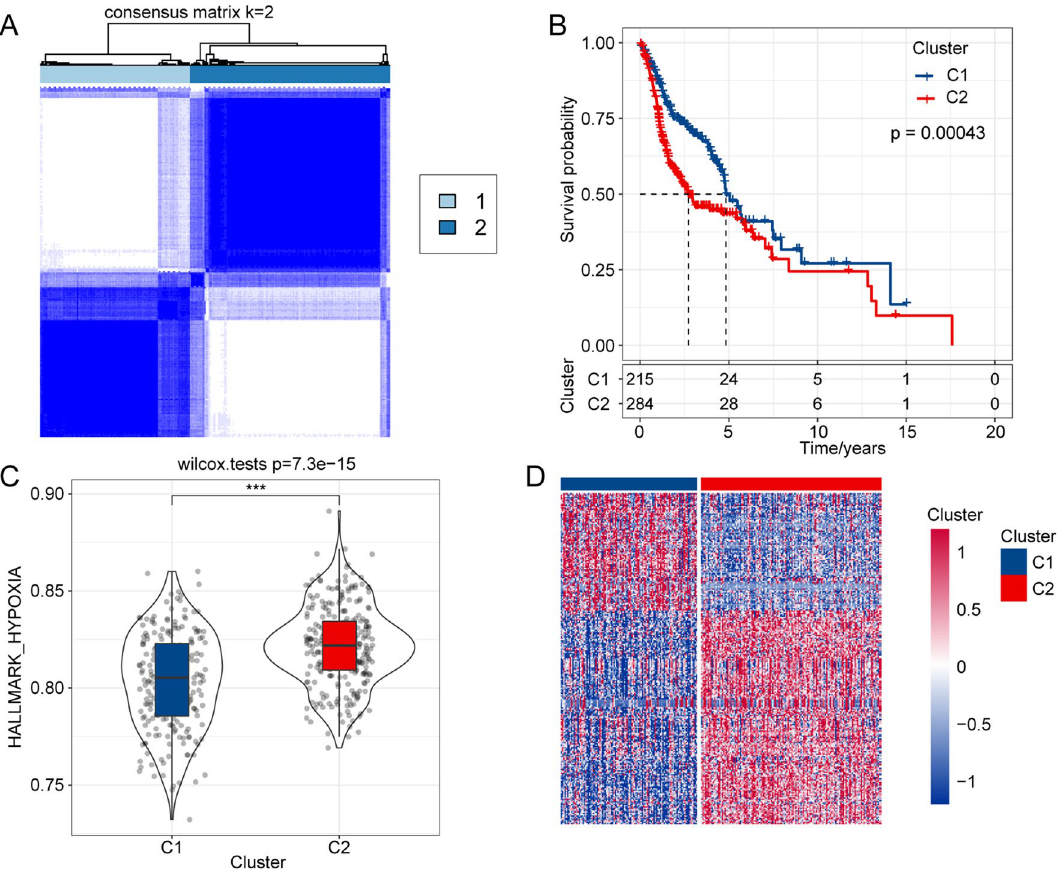
Figure 1. Identification of hypoxia-related molecular subtypes in HNSCC. ( A ) Two hypoxia-related subtypes were identified by ConsensusClusterPlus clustering analysis. ( B ) Survival curve analysis of the two distinct molecular subtypes. ( C ) ssGSEA of the molecular subtypes. ( D ) Analysis of differentially expressed genes between molecular subtypes by the limma R